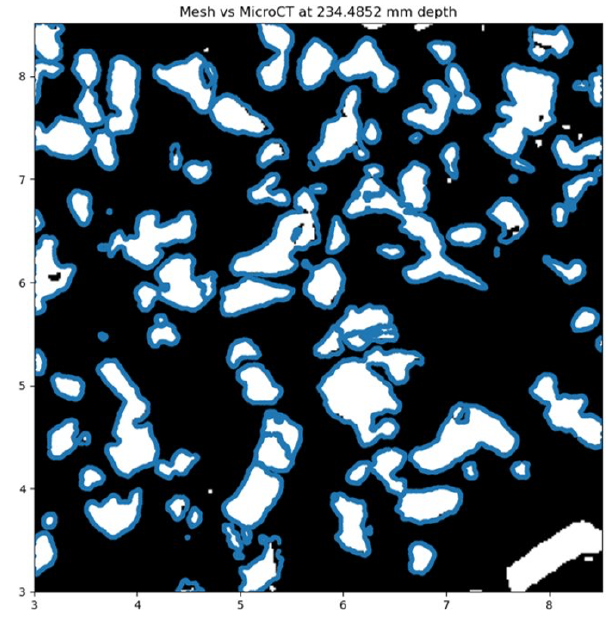
Figure 5. A 2D cross-sectional slice of a binarized µCT scan with corresponding mesh boundaries superimposed shown as the blue